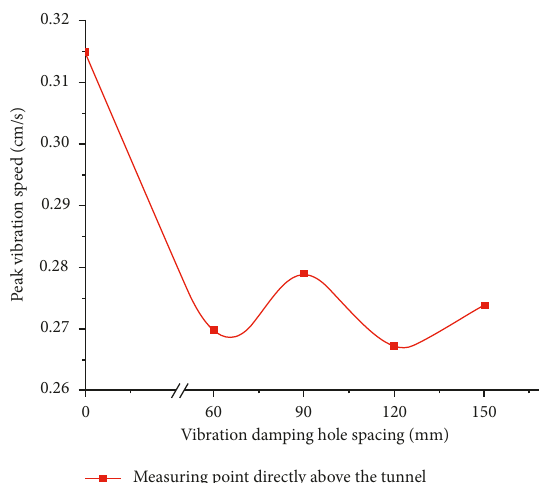
Figure 8: Peak vibration velocity of the damping hole